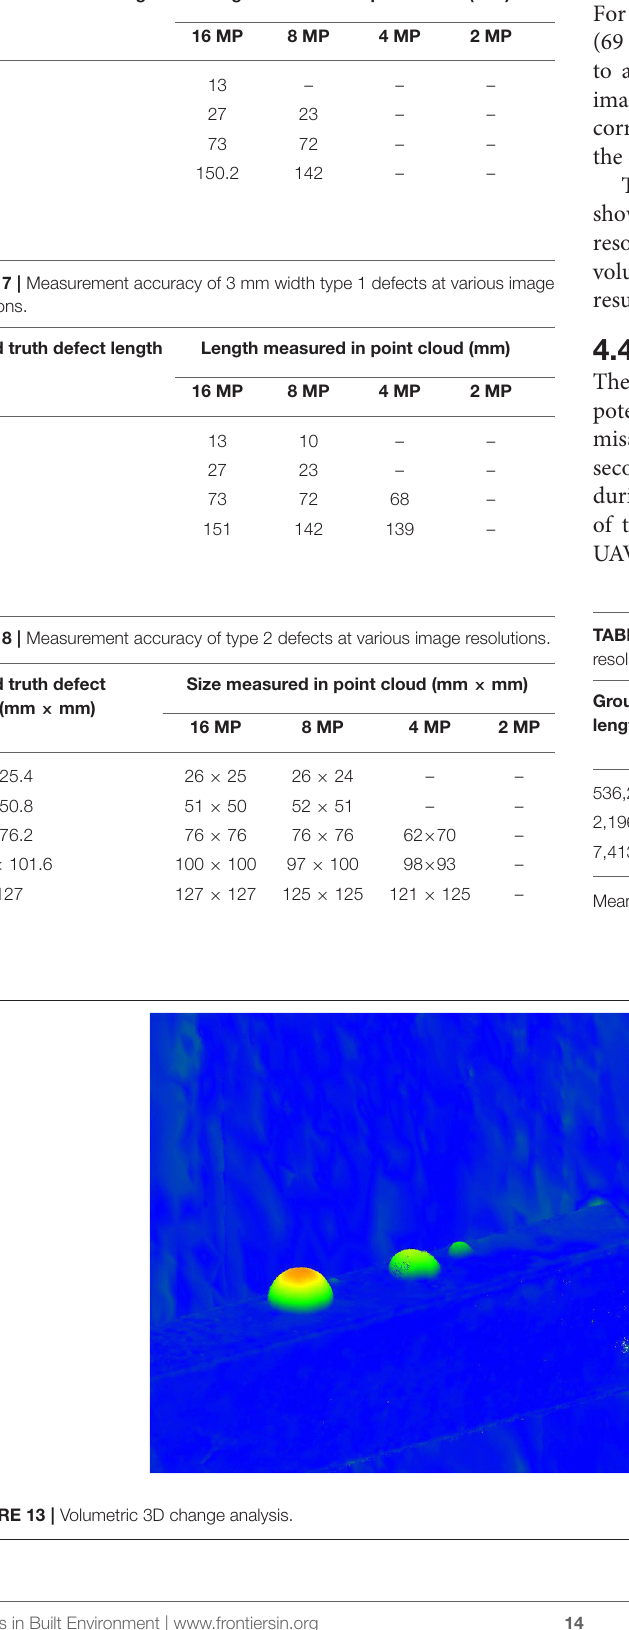
TABLE 6 | Measurement accuracy of 1 mm width type 1 defects at various image resolutions. Ground truth defect length (mm)